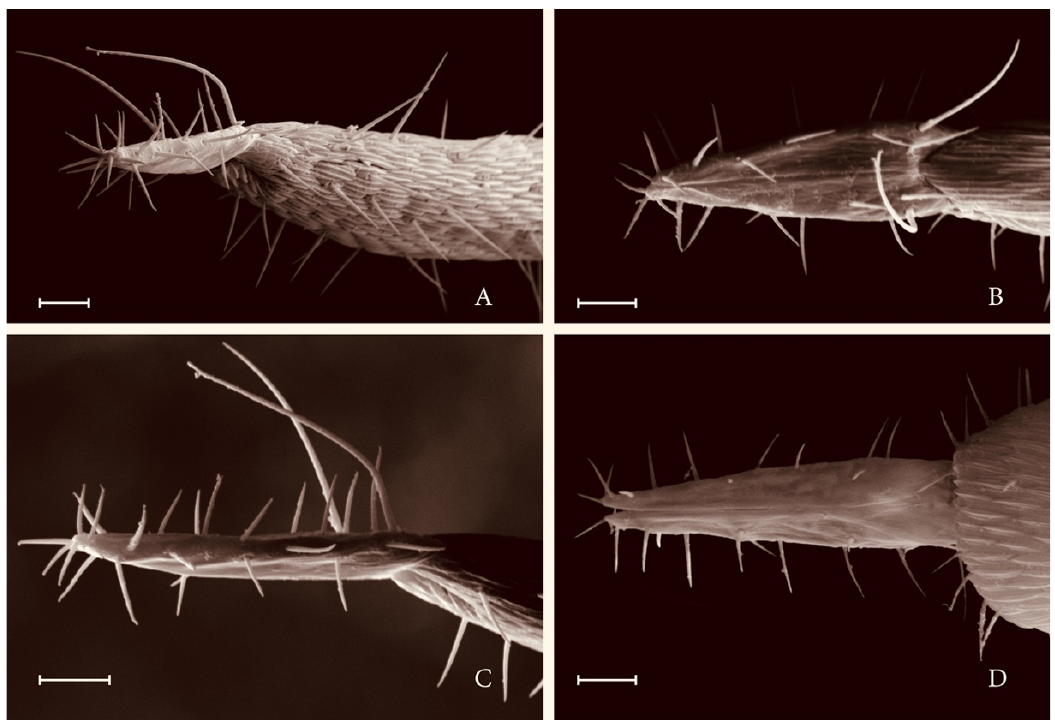
Figure 2. Stenodiplosis tectori , female cerci and part of adjoining protrusible ovipositor. ( A ), Caudolateral view. ( B ), Dorsal view (not flat). ( C ), Lateral view. ( D ), Ventral view. Scale bar = 10 μ m. 3.3. Molecular and Phylogenetic Analyses Barcode compliant sequences of 615 nt were produced from S. tectori n. sp. specimen ST-01 and the three congeners, while longer sequences of 657 nt in length were generated from all other S. tectori n. sp. specimens collected in 2019 and analyzed; all sequences have been deposited in GenBank with accession numbers indicated in Table 1. In BOLD and BLAST queries, all sequences could be assigned only to the family level of Cecidomyiidae with a similarity score ranging from 91% to 100%. To our knowledge, the sequences ob- tained in the present study are the first ones generated for Stenodiplosis . A total of seven haplotypes were recovered from the 13 S. tectori n. sp. specimens analyzed, six of which (85.7%) were “private” haplotypes, i.e., unique to a single collec- tion; one of the most common haplotypes, H5, was shared between the two localities in Greece (Table 1). The final alignment for species delimitation including the outgroup in- cluded 130 variable nucleotides out of 615, of which 61 were parsimony informative. The pairwise K2P distances within S. tectori averaged 0.0067 ± 0.0017 whereas the pairwise distances between S. tectori n. sp. and its closest relative S. sorghicola was 0.0773 ± 0.011, and the pairwise distance between its three congeners averaged 0.1163 ± 0.0116 (Table 2).